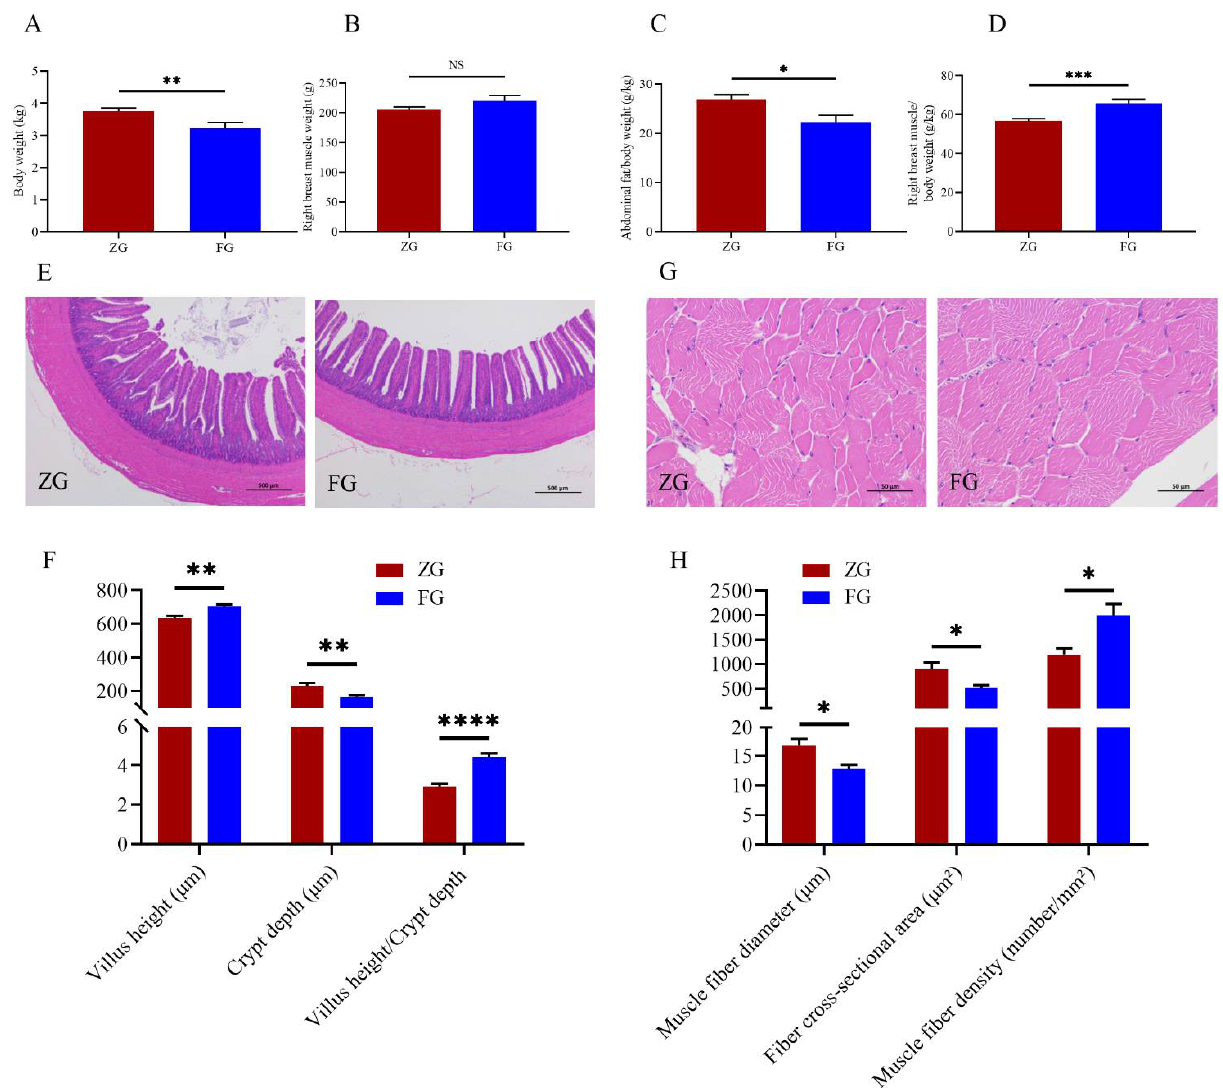
Figure 2. Growth performance and histological characteristics of the two goose breeds. ( A ) Body weight and ( B ) right breast muscle weight were measured on the final day of the experiment; ( C ) abdominal fat index and ( D ) right breast muscle index were defined as the abdominal fat mass and right breast muscle weight divided by the body weight, respectively; n = 30. H&E staining of the ( E ) ileum at 40 × magnification and ( G ) breast muscle fiber at 400 × magnification. Comparison of histological characteristics of the ( F ) ileum (villus height, crypt depth, and VH/CD) and ( H ) breast muscle fiber (muscle fiber diameter, fiber cross-sectional area, and muscle fiber density) of the two goose breeds; n = 9. Vertical bars represent the mean ± SEM. NS: No significant; * p < 0.05, ** p < 0.01, *** p < 0.001, and **** p < 0.0001 indicate significant differences between the ZG and FG. ZG, Zi goose; FG, Xianghai flying goose.